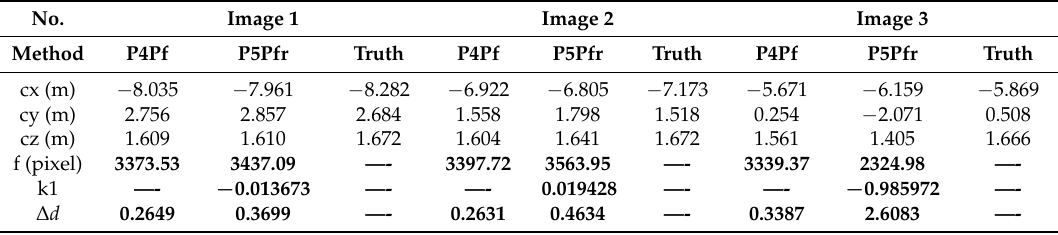
Table 1. Comparison between P4Pf and P5Pfr